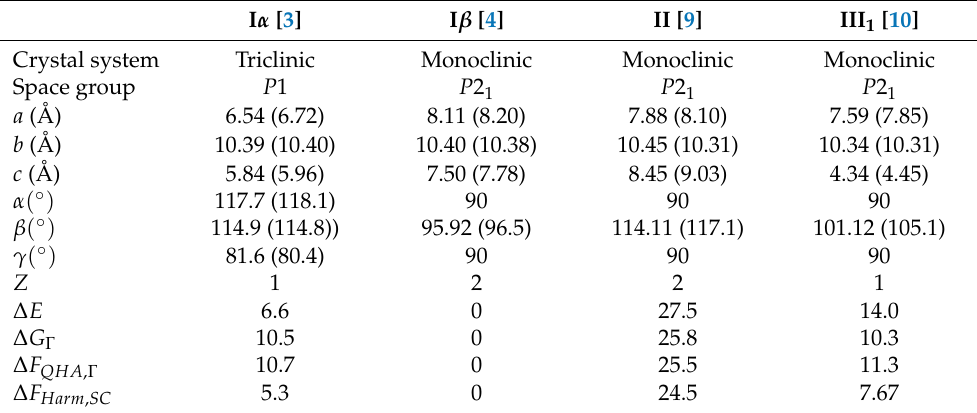
Table 1. Optimized lattice parameters and relative energies ( ∆ E , ∆ G , and ∆ F in units of of kJ/mol per Z ) of crystalline cellulose allomorphs I α , I β , II, and III 1 at the DFT-PBE-D3(ZD)/TZVP level of theory ( T = 300 K for the free energies). The corresponding experimental lattice parameters are given in parentheses, with experimental references given in the header